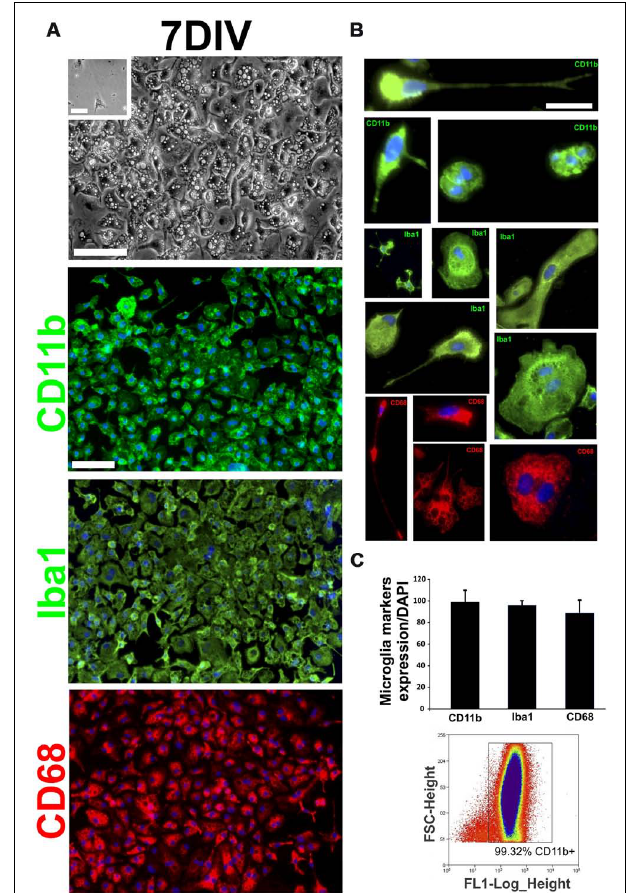
FIGURE 3 | Characterization of first stages ofAbA cells in vitro . Primary cultures of the spinal cord of symptomatic rats were established as in (Diaz-Amarilla etal., 2011) and the cell phenotypes were analyzed on DIV7. (A) The upper panel shows a representative phase-contrast image of the culture at DIV7.The inset shows the same culture obtained from non-Tg littermates where no cells could be grown.The lower panels show confocal images of cells immunostained for typical microglia markers such as CD11b, CD68, and Iba1 at 7 DIV. Scale bars: 50 μ m. (B) Characterization of different typical microglia phenotypes present at 7 DIV, cultured fromTg symptomatic rats. Scale bar: 25 μ m. (C) Quantification of the microglia markers expression (CD11b, CD68, and Iba1) in culture at 7 DIV, counting cell positive for microglia marker respect to the total number of nuclei labeled with DAPI (upper panel).Typical data from flow cytometry showing that 99% of cells were CD11b + .The data are representative of three independent